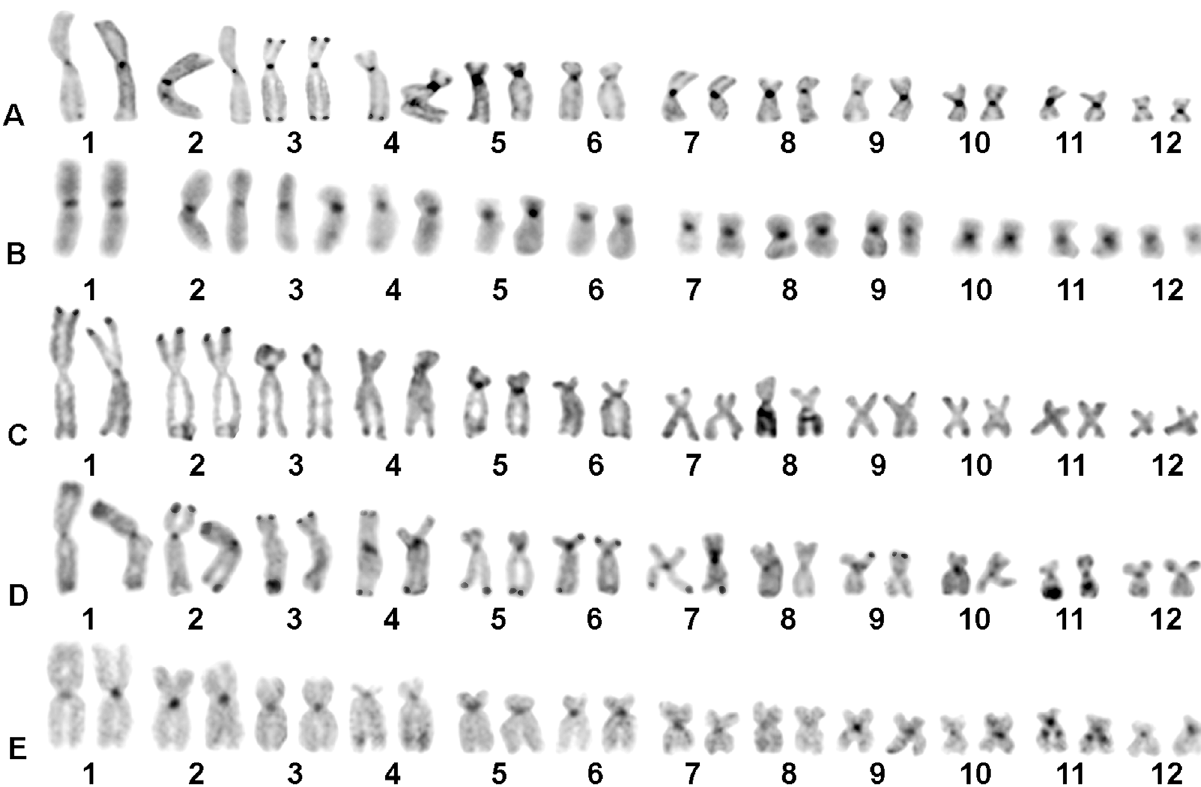
Figure 2 - C-banded karyotypes of Scinax species: (A) S. boesemani , (B) S. camposseabrai , (C) S. garbei , (D) S. pachycrus and (E) S. x-signatus .